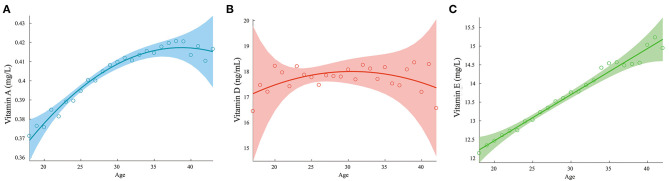
Variation of vitamin levels with age. (A) Vitamin A; (B) Vitamin D; (C) Vitamin E.